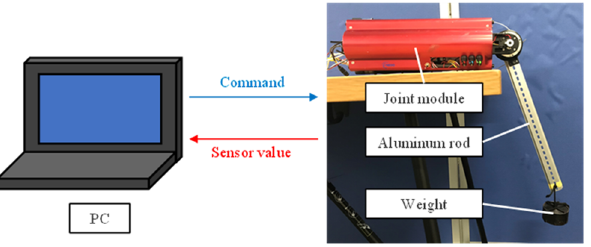
Figure 10. Diagram of the experimental environment for viscous element experiment.